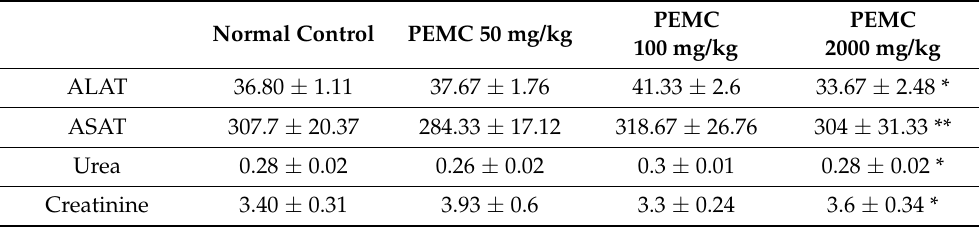
Table 2. Biochemical analysis on hepatic and renal biomarkers in the serum of mice treated with different doses of the polyphenol-enriched fraction extracted from Myrtus communis. Normal Control